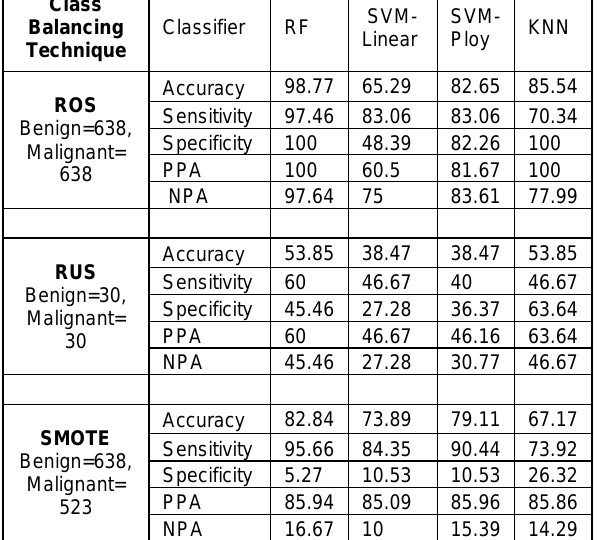
Class Balancing